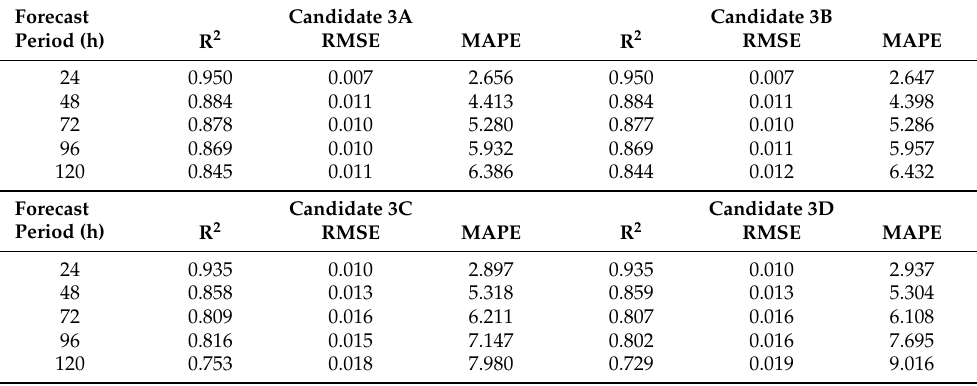
Table A5. The validation results of the combined model(HWL) fitted with